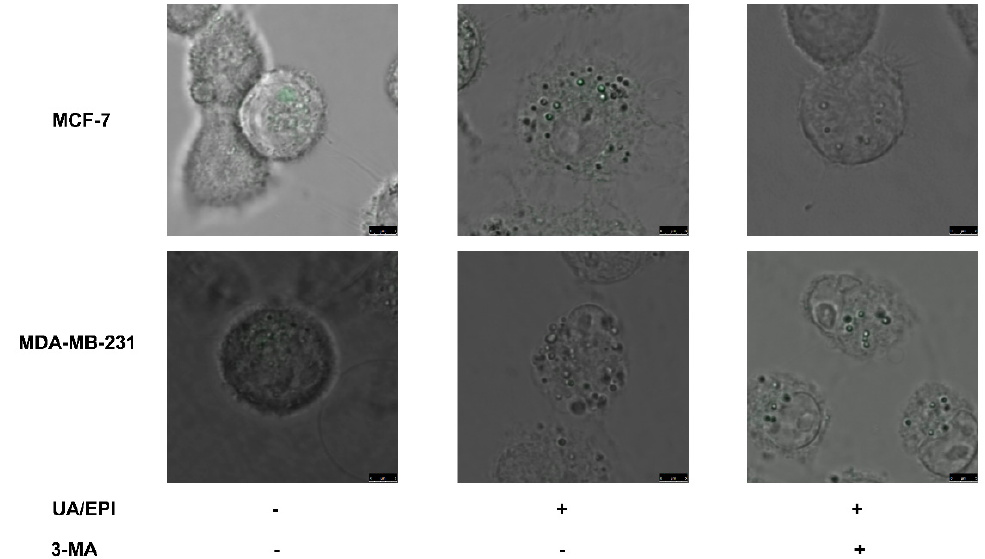
Figure 5. Detection of autophagy by MDC staining in breast cancer cells. MCF-7 and MDA-MB-231 cells were pre-treated with or without 3-MA (1 mM) for 4 h, followed by UA/EPI incubation for another 24 h, and then incubated with 0.05 mM monodansylcadaverine (MDC) for 1 h. The mor- phological changes were then examined by fluorescence microscopy. Scale bar = 5 µ m. Autophagic vacuoles distributed within the cytoplasm or perinuclear regions stained by MDC appear as distinct dot-like structures.